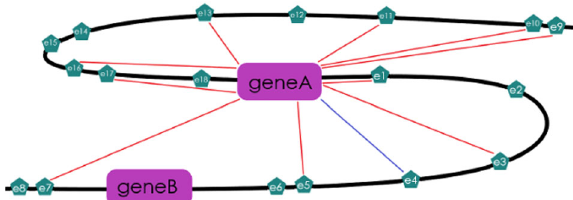
Fig. 4 Negative enhancer-gene examples. The diagram illustrates how for each positive enhancer-gene example (gene A:e4 marked by a blue line), ten enhancers targeting the gene from the positive example (gene A) were randomly chosen from those in the complete set of negative examples to be included in the dataset (Ten enhancers connected to gene A by a red line). This was done so that the negative examples would come from a cellular environment similar to the positive examples. This was only performed for the HepG2, HCT116, and MCF7 datasets. The K562_1 and K562_2 datasets are from two different CRISPR datasets that reported negative and positive examples within the same ~1 Mb long region. Therefore, the experimental design for these two datasets ensured that the negative and positive examples came from the same genomic